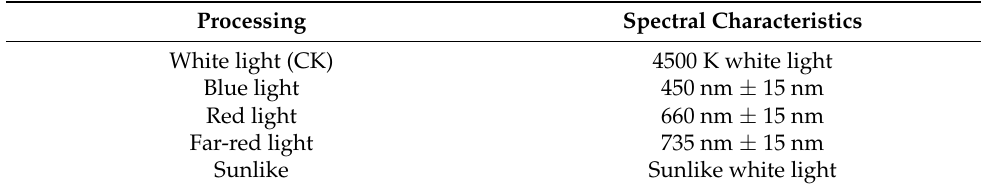
Table 1. Information on the five light treatments of the